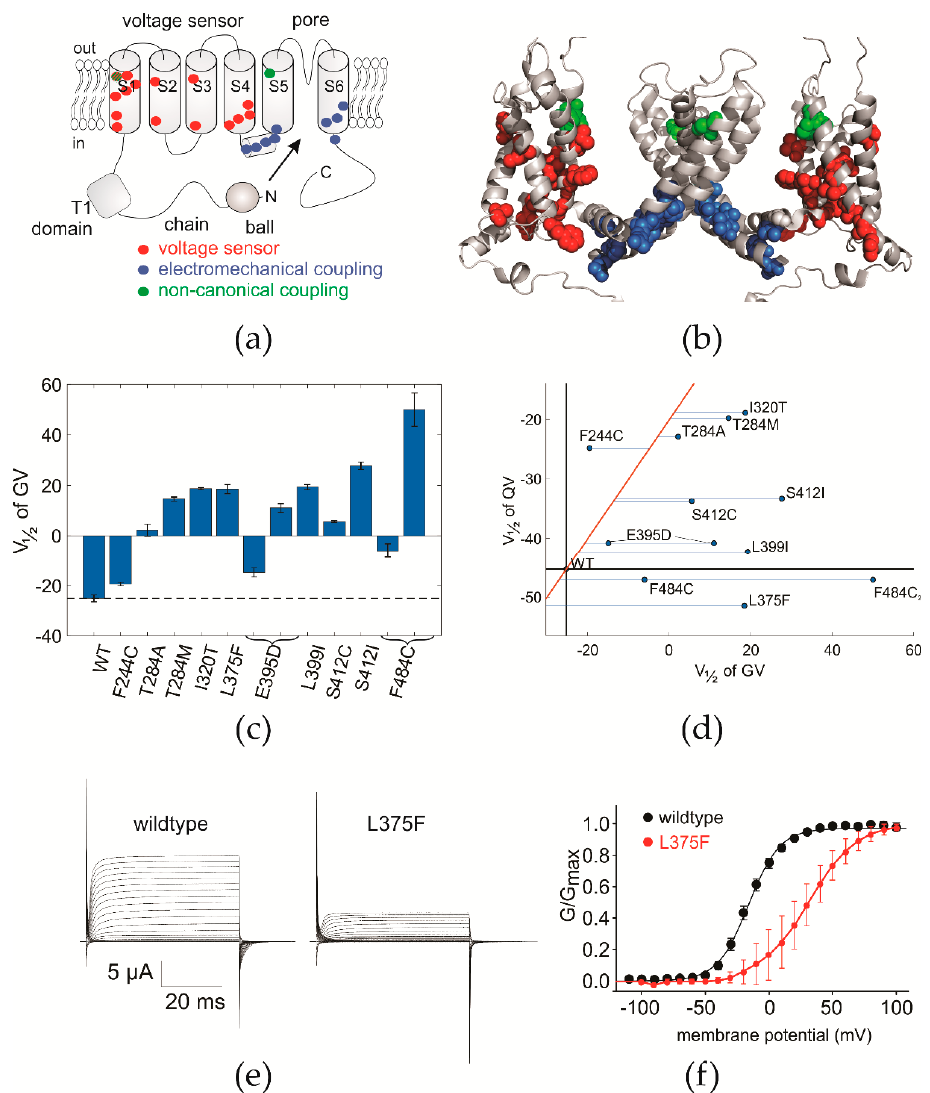
Figure 1. ( a ) Topology of Kv1.1 and location of the identified mutations causing Episodic ataxia type 1 (EA1). Red denotes the voltage sensor mutations, blue the mutations in the region of electromechanical coupling and green those in the position for non-canonical coupling. ( b ) Position of the mutations in the 3D structure (PDB: 3LUT). Colors coded as in ( a ). ( c ) Midpoint of activation for the tested mutants. The dashed line indicates wildtype. Midpoints and their standard error were obtained from fit to sigmoidal curves (see Materials and Methods). E395D and F484C had to be fitted to a convolution of 2 sigmoidal curves ( n = 3–6). ( d ) Midpoints of activation for pore opening (GV) and voltage sensor movement (QV). The red line shows a parallel shift of both QV and GV. The arrows indicate a separation ( green ) or convergence ( red ) of QV and GV. ( e ) Current traces elicited from wildtype and Shaker-L375F upon response to depolarizing pulses from a holding potential of − 90 mV to voltages between − 120 and +100 mV. ( f ) Current voltage relationship of wildtype and the furthest shifted of Shaker-L375F.